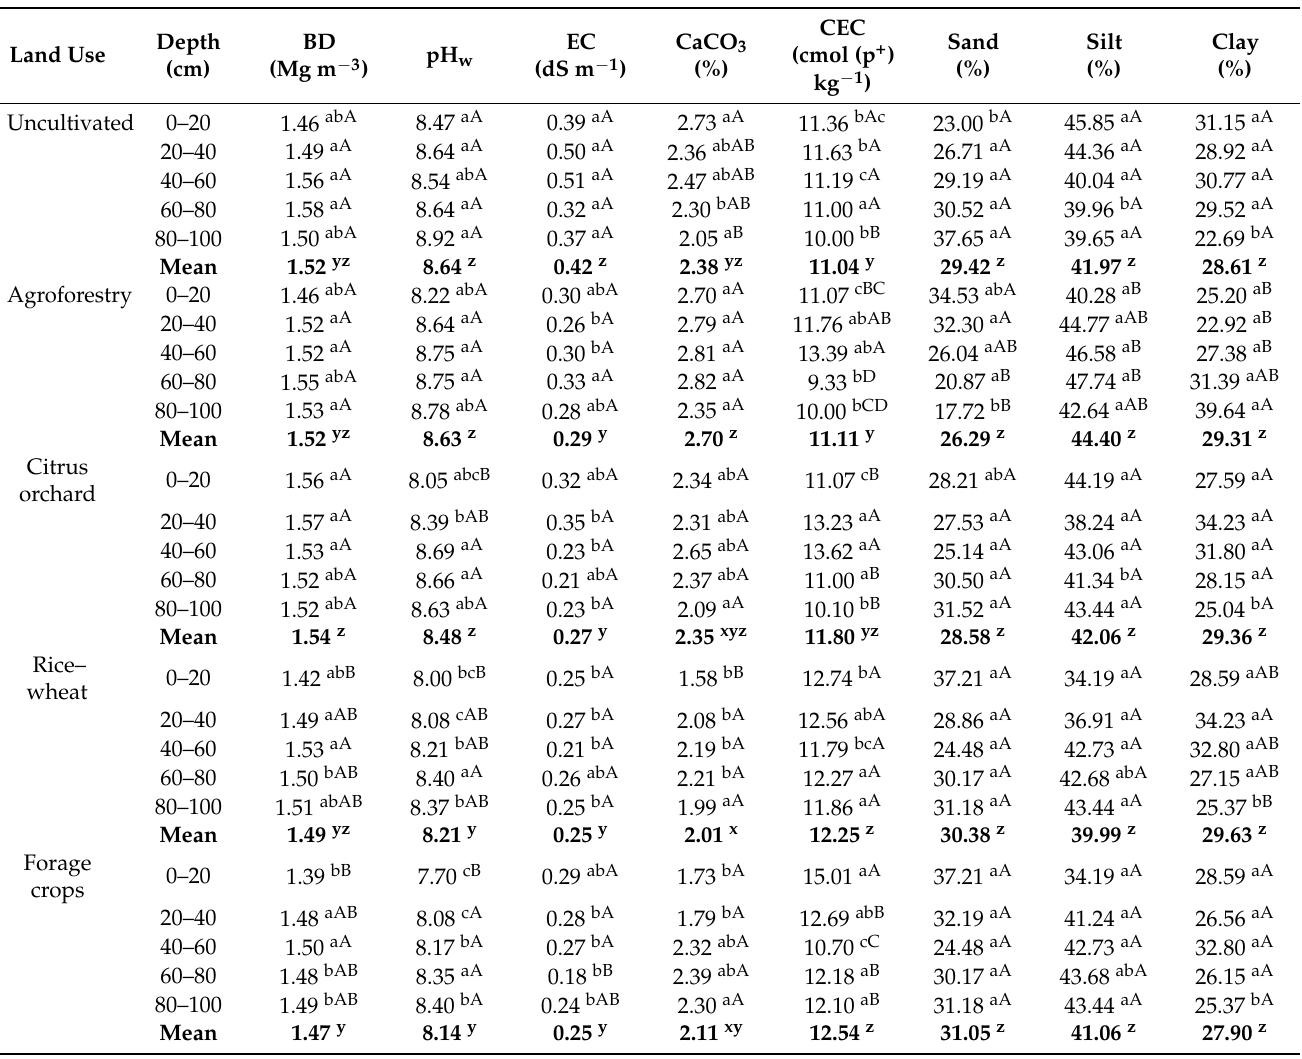
Table 2. In a hot, arid climate, the depth-wise distribution of soil attributes as influenced by various land use